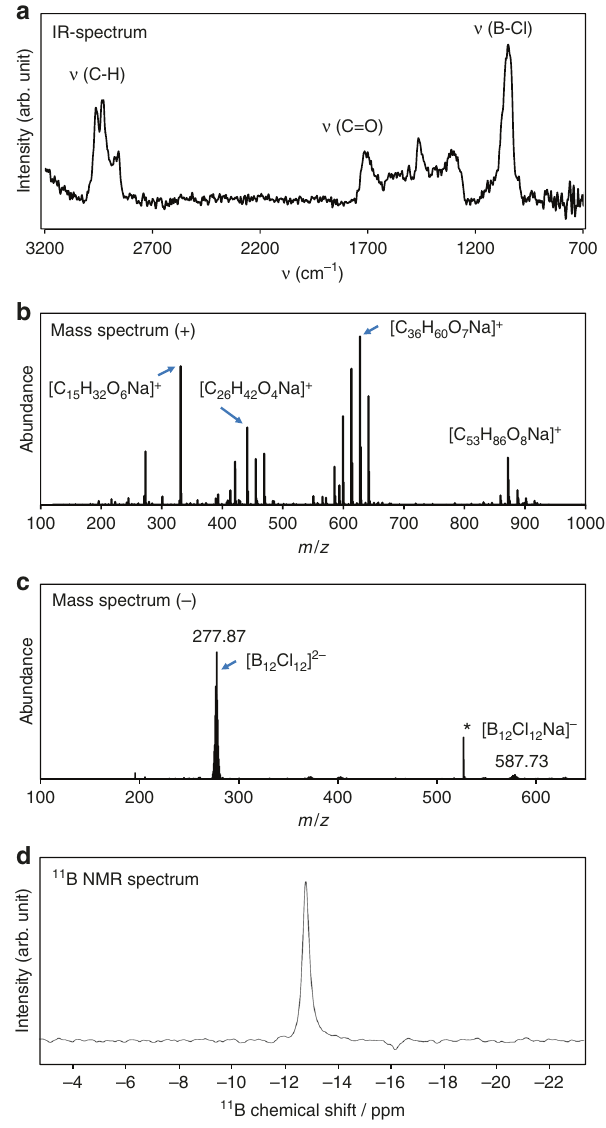
Fig. 2 Chemical analysis of the layers produced by soft landing of [B 12 Cl 12 ] 2 − onto FSAM. a In-situ IR spectrum acquired during ion deposition, Ex-situ analysis: b positive and c negative mode nano-DESI MS spectra of the deposited spot showing a distribution of hydrocarbons, and the intact deposited anions, respectively. The peak marked with a star was identi fi ed as solvent signal, d 11 B NMR signal detected from soft-landed [B 12 Cl 12 ] 2 − dissolved in methanol-d4. The chemical shift of [B 12 Cl 12 ] 2 − was − 13.48 ppm as referenced to an external sample of 189mM boric acid in D 2